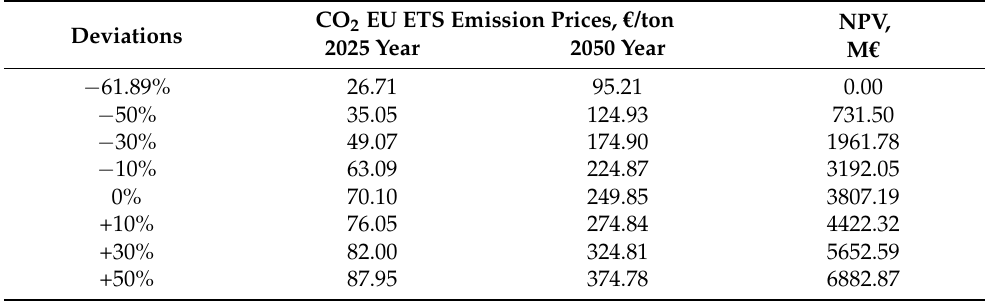
Table 7. The results of sensitivity analysis of NPV calculation for the scenario with CCUS.